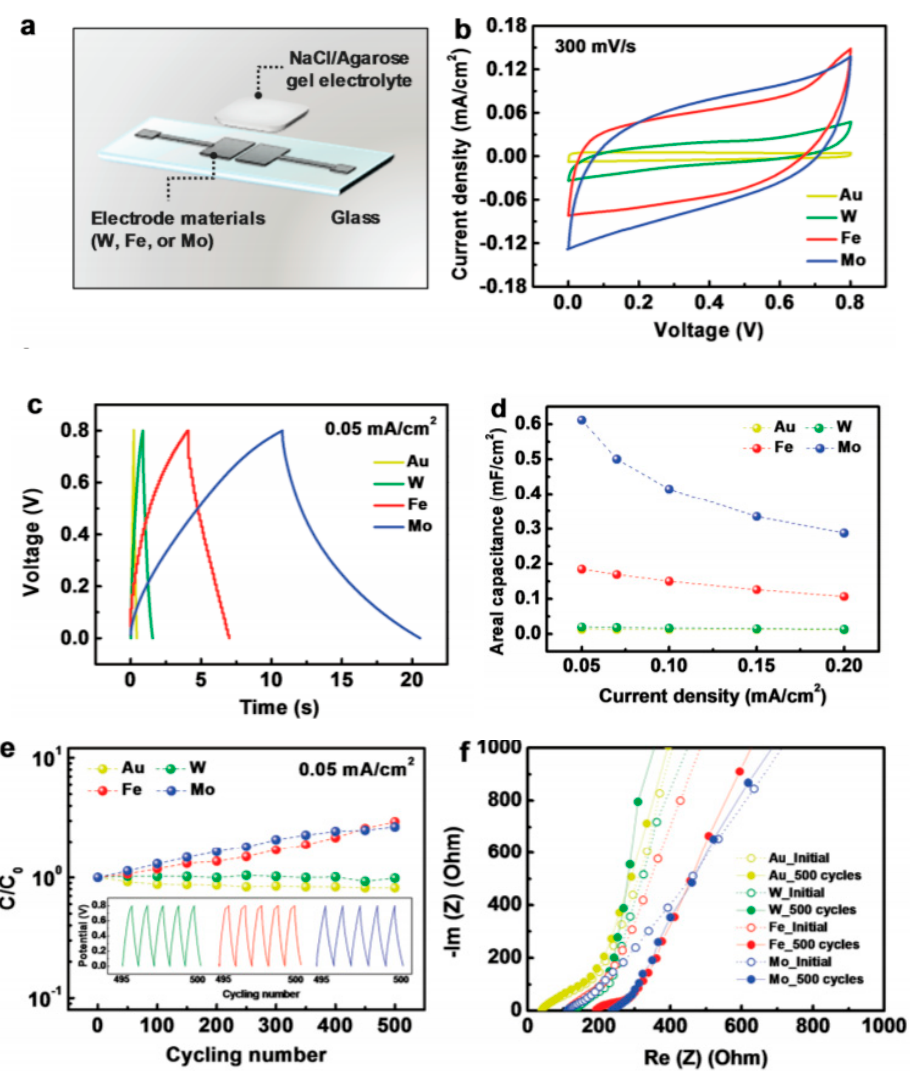
Figure 26. ( a ) Scheme of a supercapacitor made of biodegradable metal electrodes (W, Fe, or Mo) and an agarose gel electrolyte. ( b ) and ( c ) Electrochemical characterizations. ( d ) Capacitance as a function of current density. ( e ) Charge / discharge curves (normalized capacitance). ( f ) Impedance (Nyquist) plots of the supercapacitor before and after 500 charge / discharge cycles. Reproduced from [119]. Copyright © 2017 Wiley and Sons.